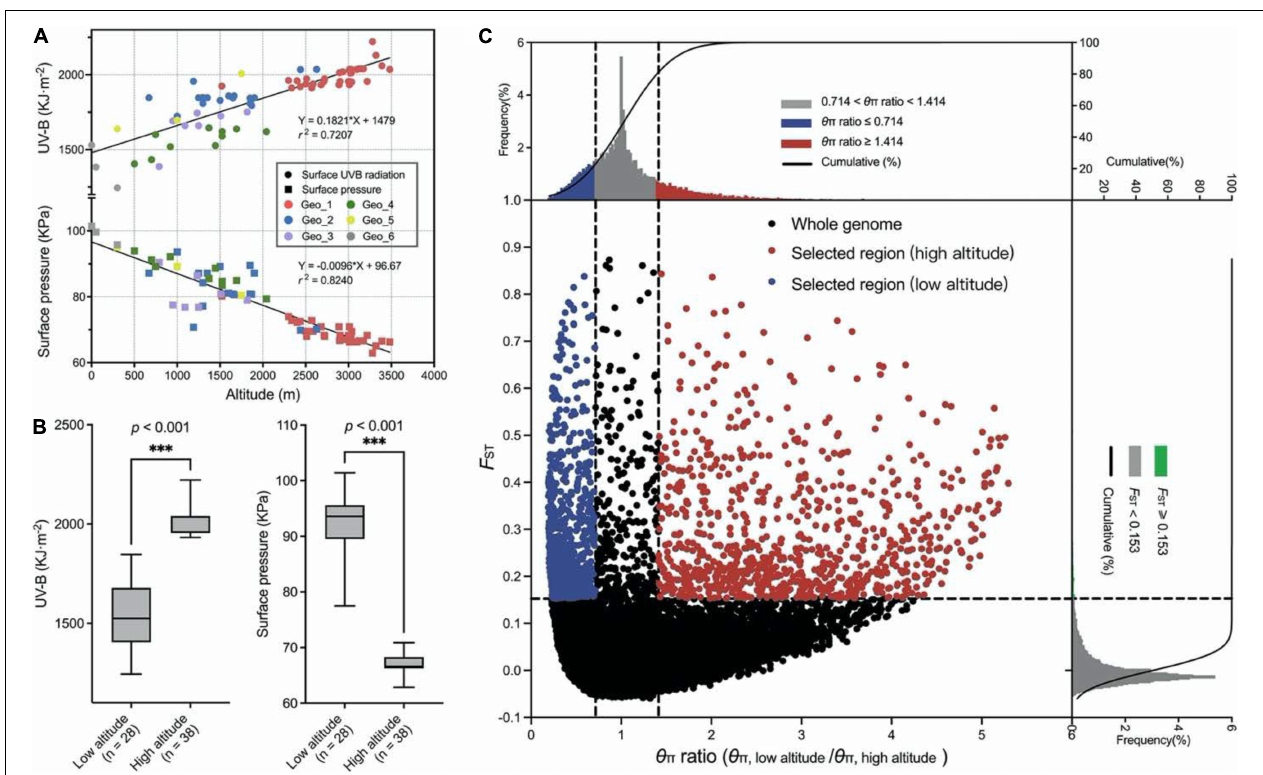
FIGURE 2 | Selective sweep analysis. (A) Regression analysis between the UV-B, surface pressure, and altitude for 210 E. sibiricus genotypes. (B) Two boxplots for UV-B and surface pressure among low-altitude and high-altitude genotypes. Whiskers extend to data ranging from min to max values. Differences between the two pools were statistically analyzed based on the Welch’s test. (C) Distribution of θ π ratio ( θ π , low altitude/ θ π , high altitude) and F ST value. The horizontal dashed line represents the top 5% F ST distribution. The left and right dashed lines represent 20% left and right tails of the θ π ratio distribution. The red points were identified as selected regions for high-altitude